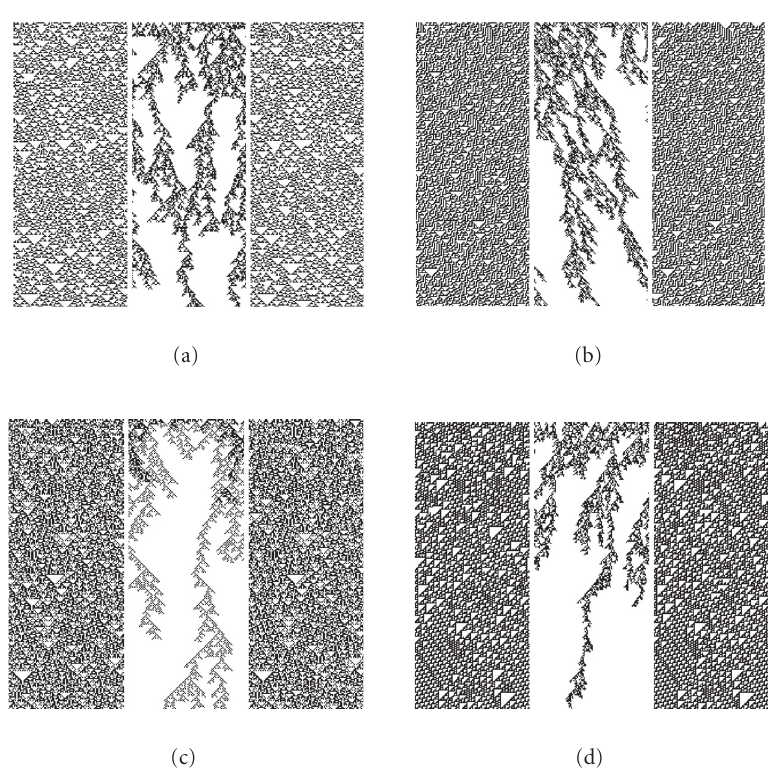
Figure 1. Spatio-temporal patterns just above the synchronization transition. The left and the right plots show 250 successive states of the two coupled automata and the central plot is the corresponding di ff erence automaton for the rules 22, 30, 90, and 110. The number of sites is L = 100 and the coupling probability is p = 0 .